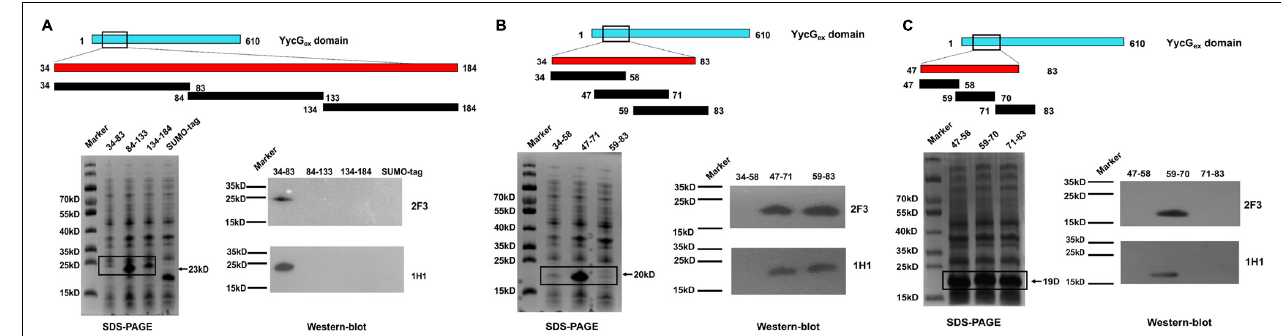
FIGURE 4 | Epitope mapping of YycG ex mAbs within YycG ex domain. YycG ex domain was truncated into fragments of distinct sizes harboring an N-terminally fused SUMO-tag, as shown in the schematic diagrams; the specific recognition of the truncation fragments (TFs) by YycG ex mAbs was assessed through Western blotting.